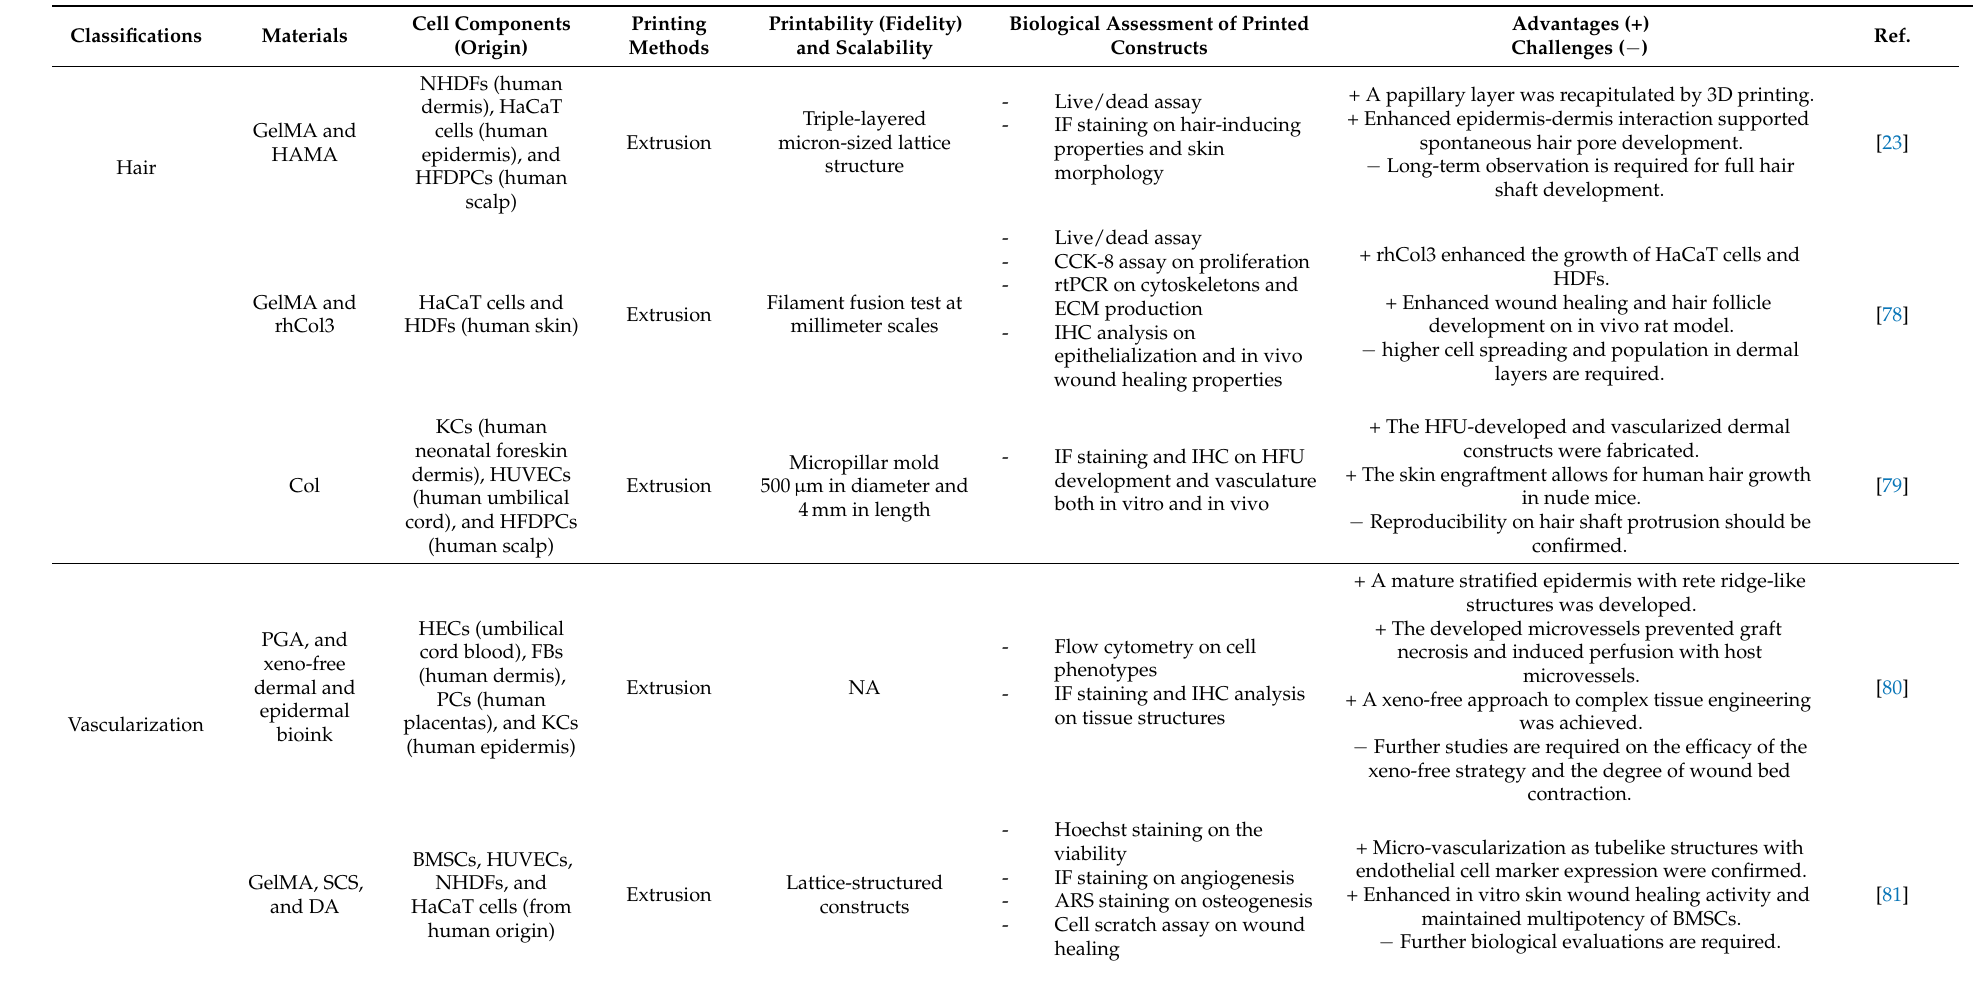
Table 2. Structural advances in 3D bioprinting of